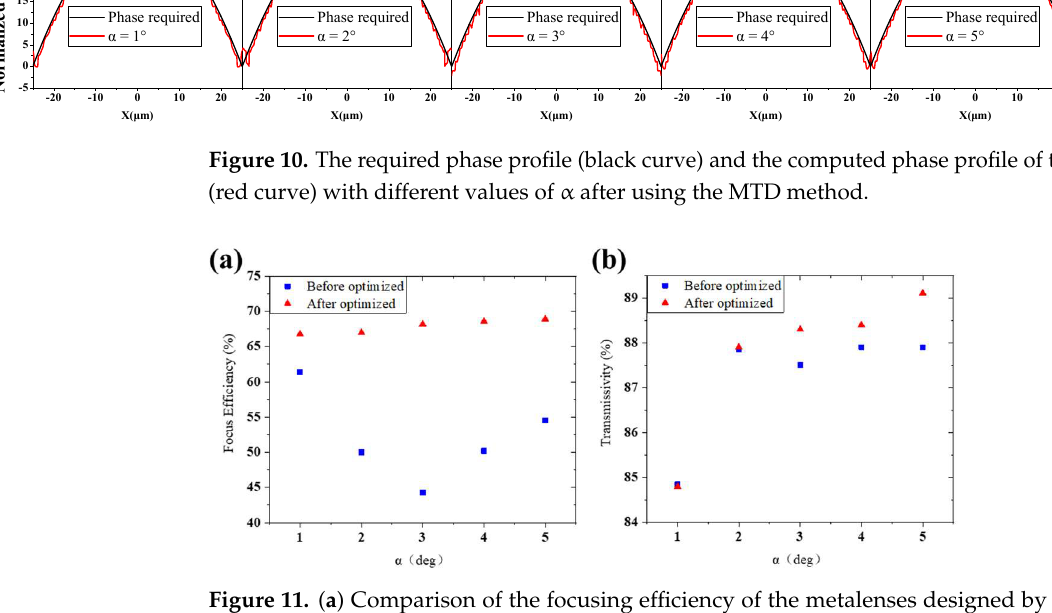
Figure 11. ( a ) Comparison of the focusing efficiency of the metalenses designed by MTD method (red triangles) and without using it mentioned in Section 2.2.2 (blue rectangles). ( b ) Transmissivity of metalenses.